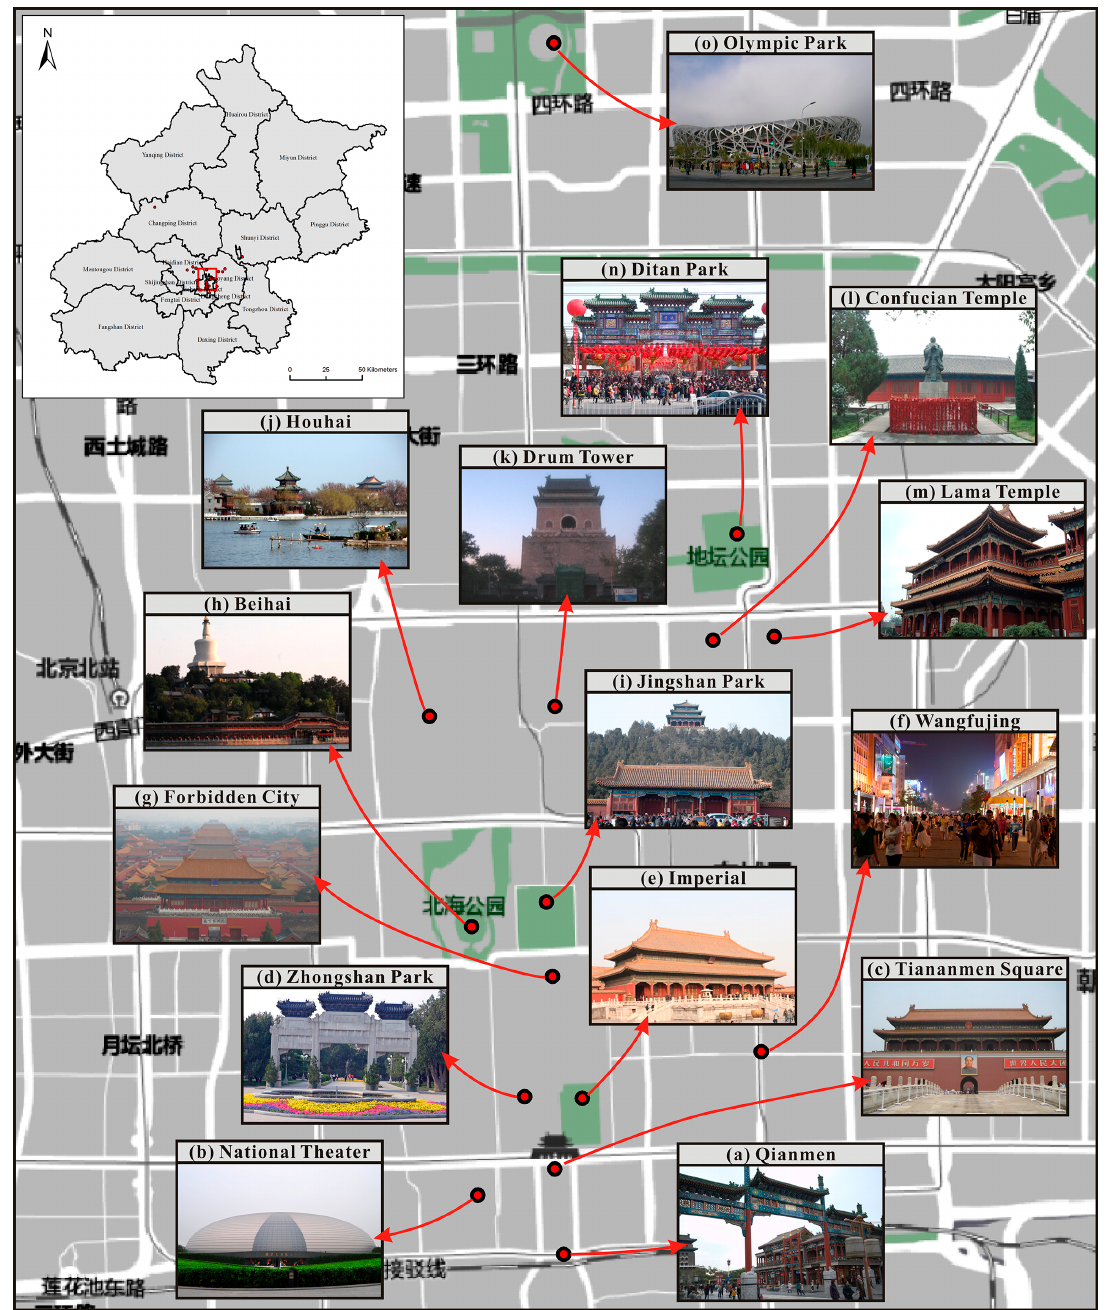
Figure 8. Cluster results of TU-DJ-Cluster (These photos in Figure 8 are all licensed under the Creative Commons Attribution